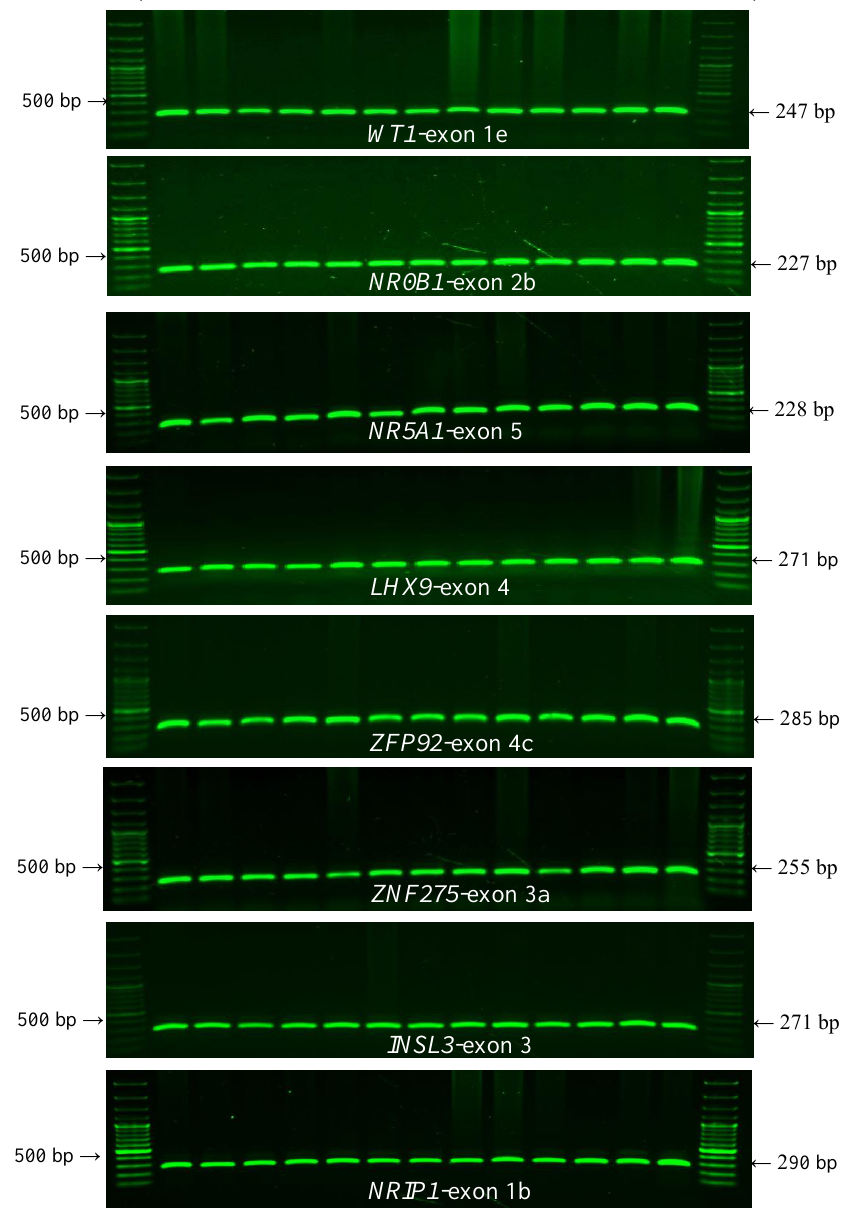
Figure 1. Representative banding patterns for the WT1 (NM_024426.6), NR0B1 (NM_000475.5), NR5A1 (NM_004959.5), LHX9 (NM_020204.3), ZFP92 (NM_001136273.2), ZNF275 (NM_001080485.4), INSL3 (NM_001265587.2), and NRIP1 (NM_003489.4) genes. All exons were amplified by ( α - 32 P)- dCTP-PCR, and one representative exon is shown for each gene. The arrows indicate 500 bp, and 100 bp indicates the molecular weight marker (100–1500 bp). C1 and C2 are unrelated healthy subjects. P1–P11 are patients clinically classified with POI. The expected sizes for the amplified exons are shown on the